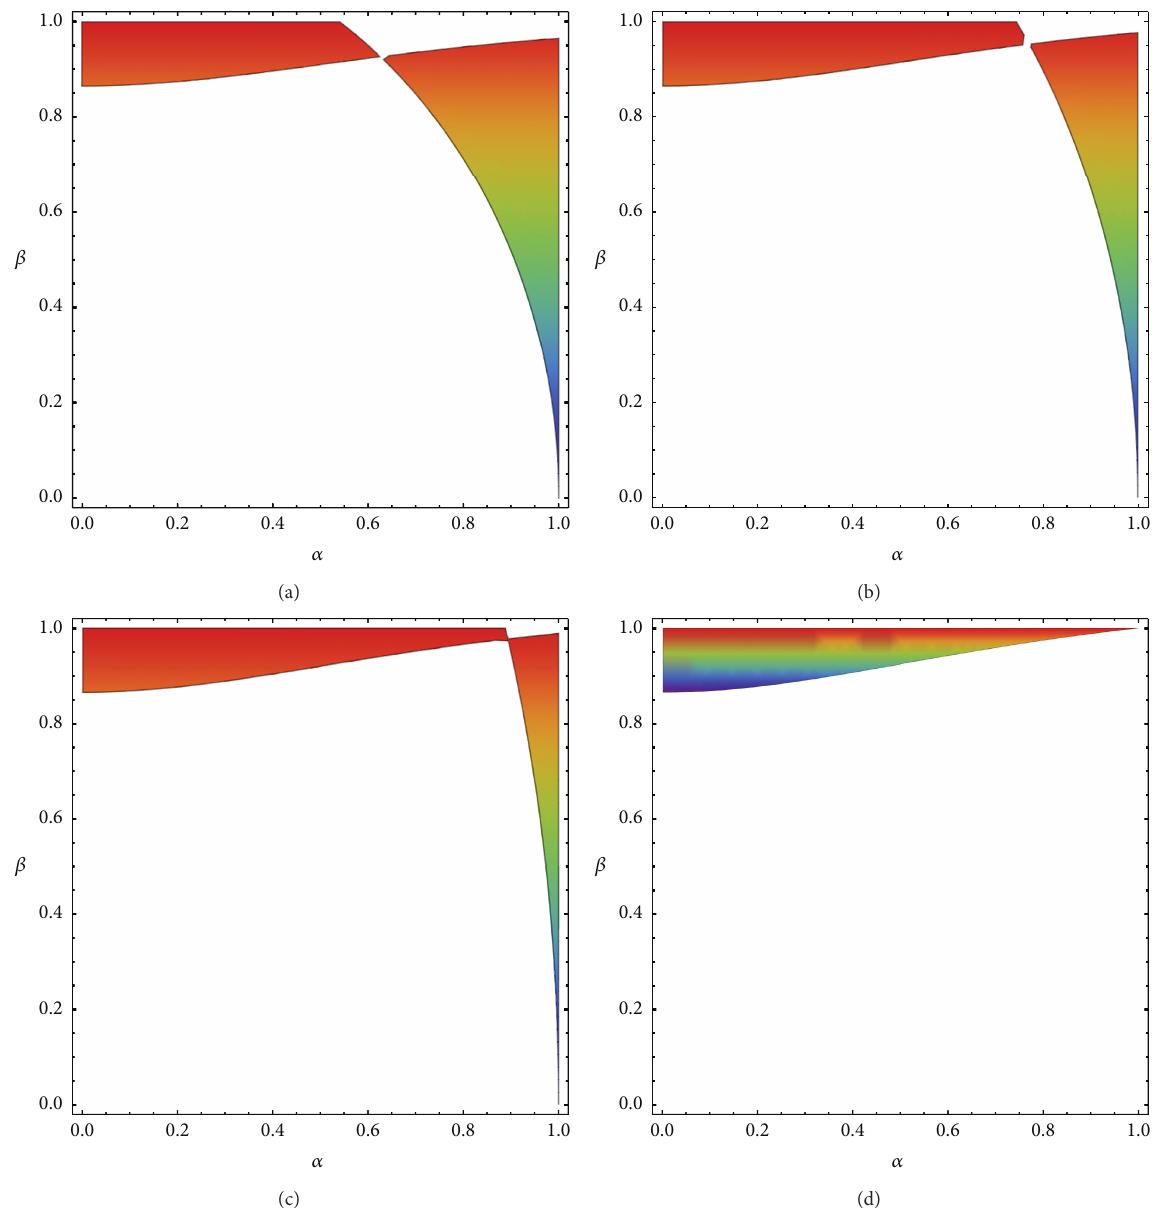
Figure 7: Cross sections of the central configurations region in the general case when 𝑀, 𝑚 0 > 0 and (a) 𝐶 = 0.7 , (b) 𝐶 = 0.8 , (c) 𝐶 = 0.9 , and (d) 𝐶 = 1 give the case with four equal masses and a varying central